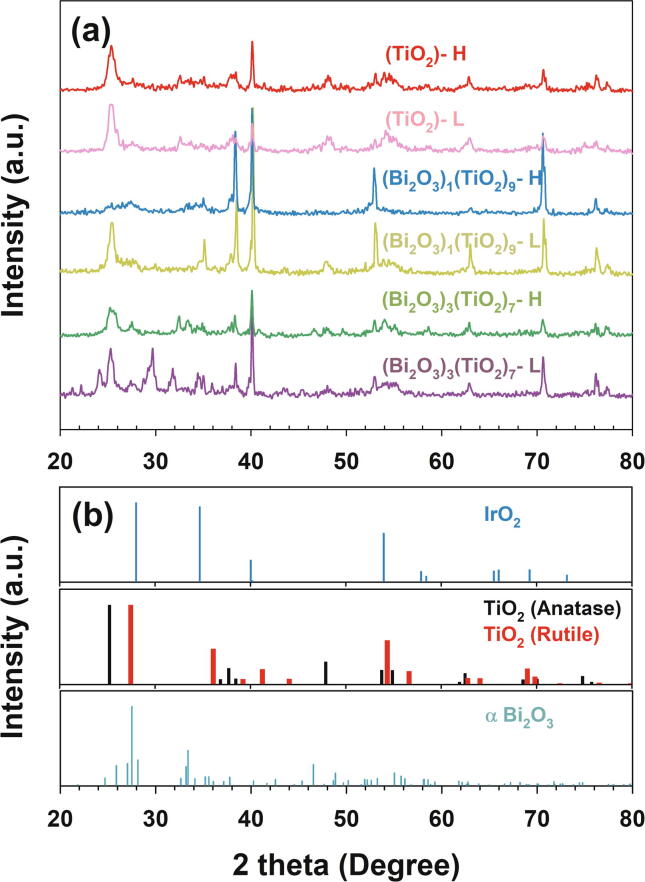
(a) X-ray diffraction patterns of (a) IrTaOy/(Bi2O3)x(TiO2)1−x heterojunction anodes (x = 0, 0.1, and 0.3, mass loading = high (H) and low (L)), referenced with (b) IrO2, TiO2 (anatase, rutile) and Bi2O3.